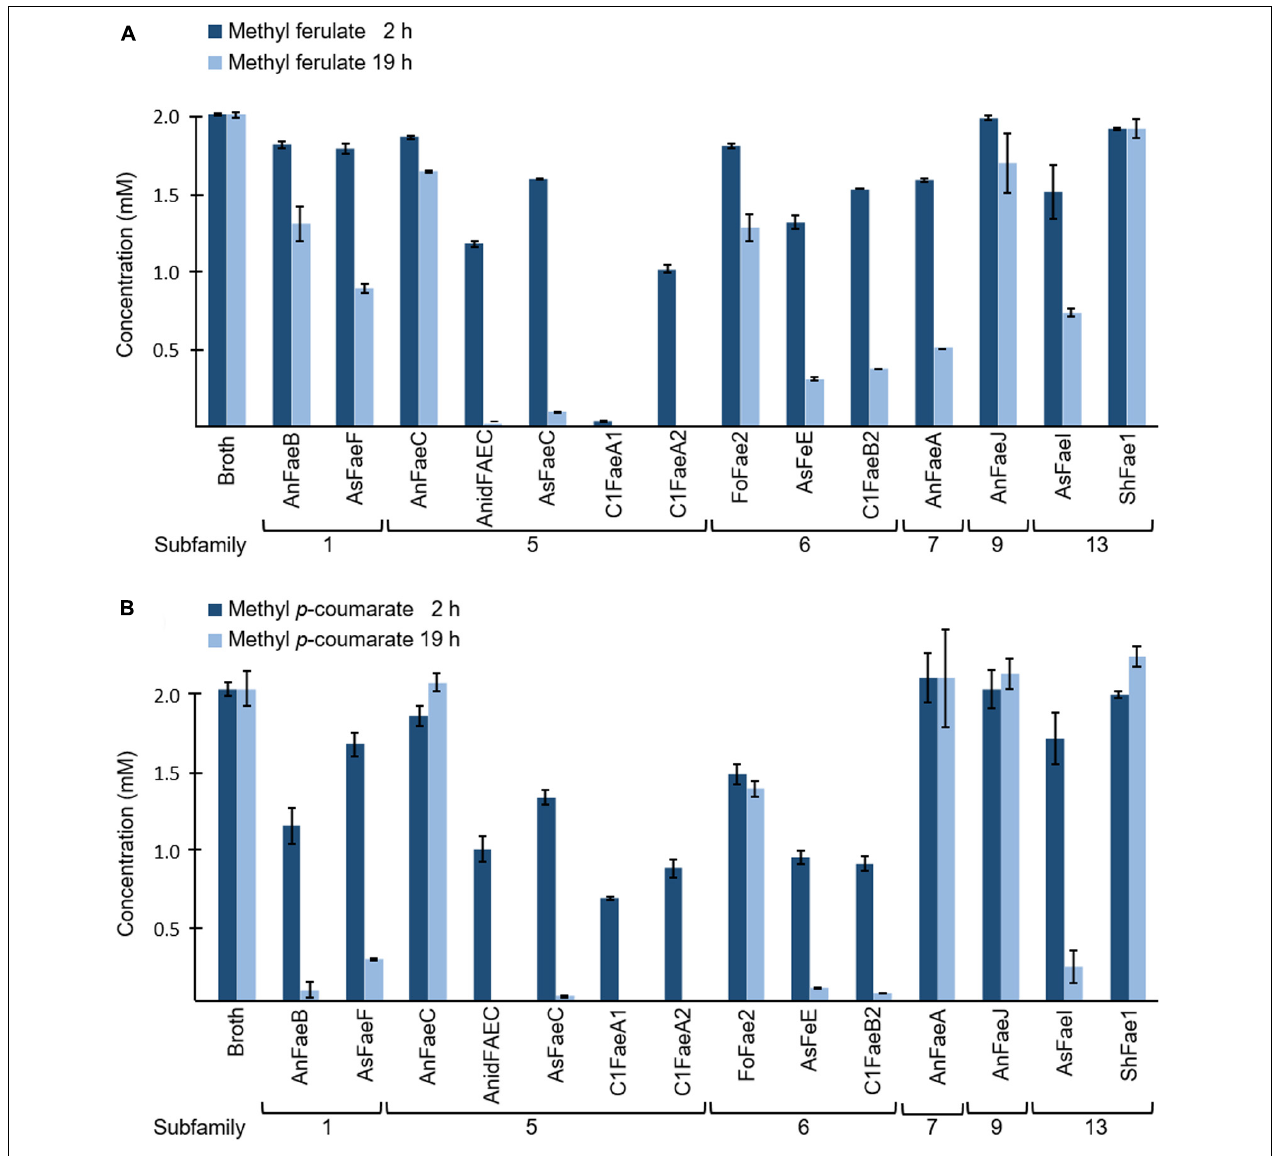
FIGURE 2 | Specificity of FAEs toward (A) methyl ferulate (MF) and (B) methyl p -coumarate (MpC). Both methyl ferulate (2 mM) and methyl p -coumarate (2 mM) were incubated with and without (broth) FAEs at 37 ◦ C for 2 and 19 h. The reduction in methyl ferulate and methyl p -coumarate concentration was measured in duplicate using UHPLC-UV ( n = 2). The broth is the culture supernatant of P. pastoris , which was grown without FAE insertion (negative control). Error bars represent the average standard deviation based on determined absolute